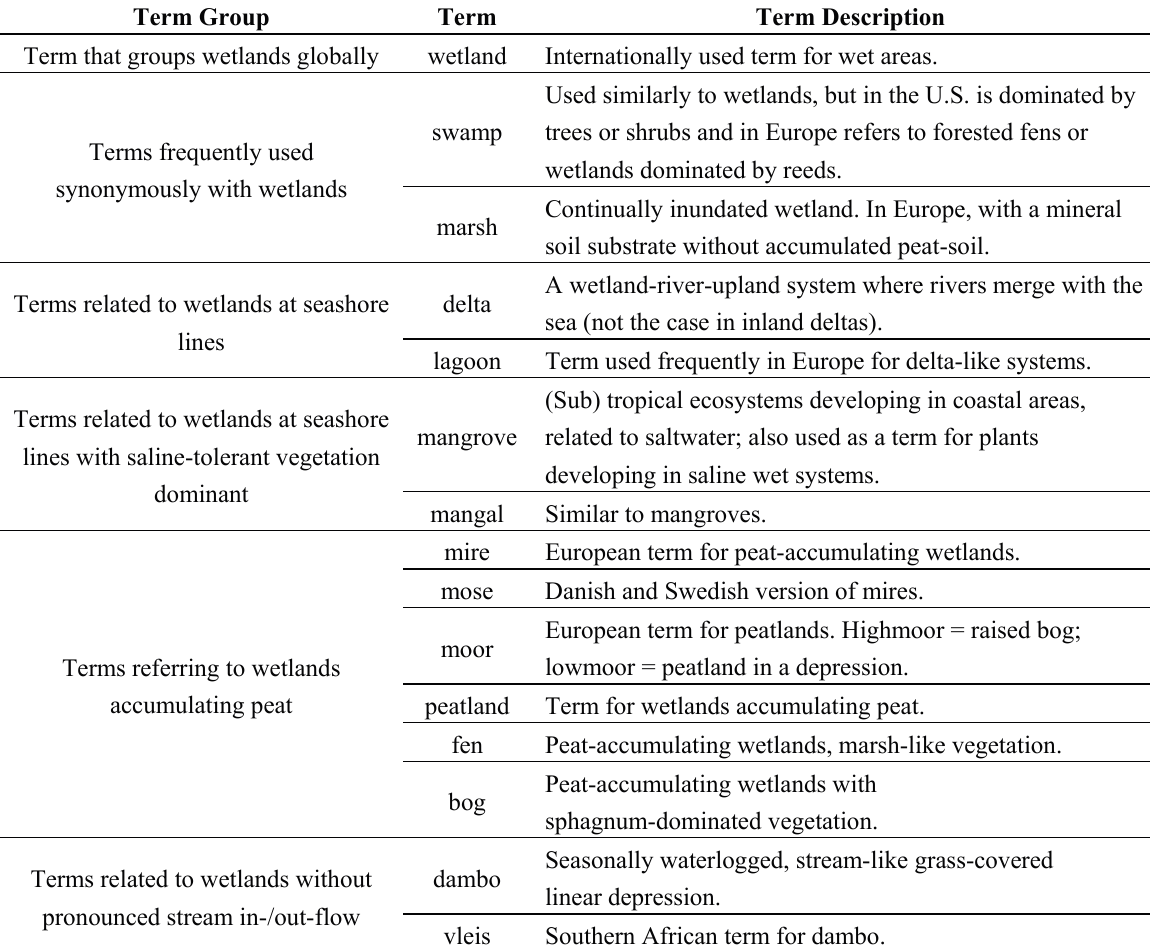
Table 1. Excerpt of an exemplary list of wetland terms and an exemplary attempt at grouping. Term Group Term Term